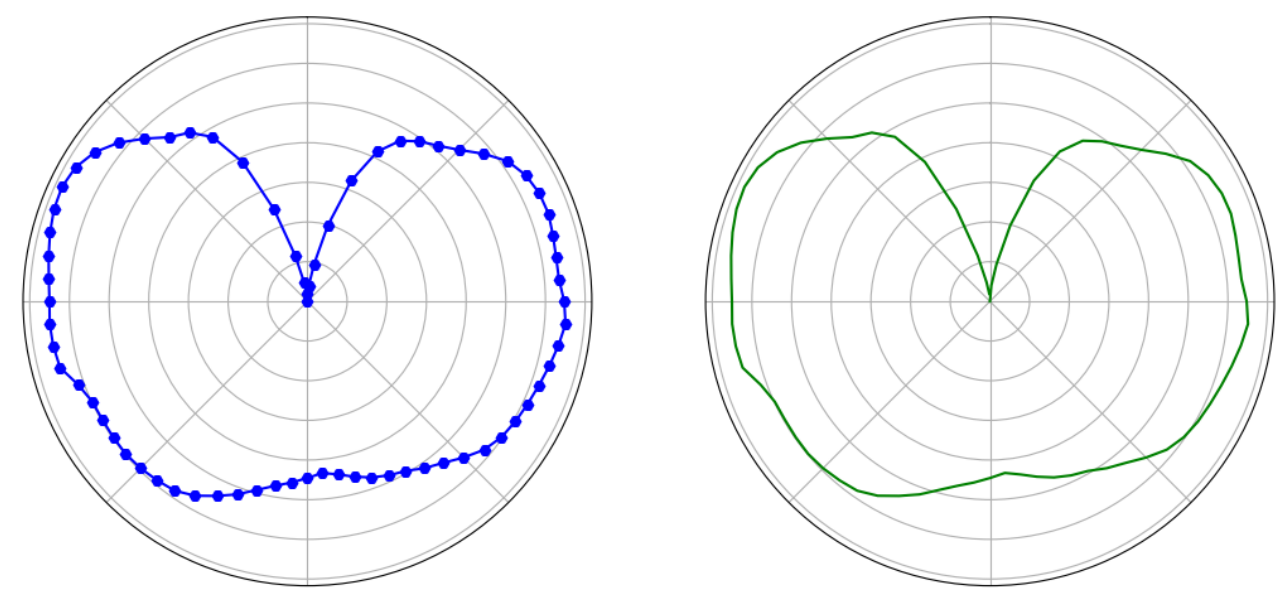
Figure 11. The result of the example code of Section